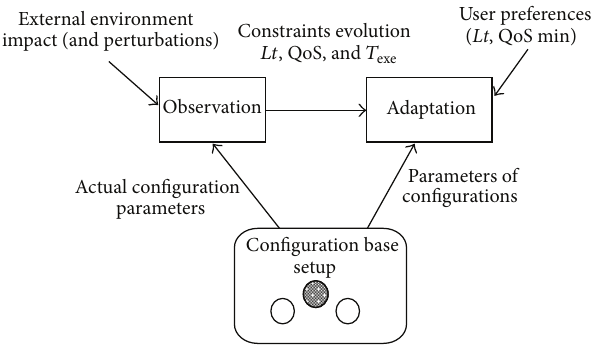
Figure 1: Adaptation